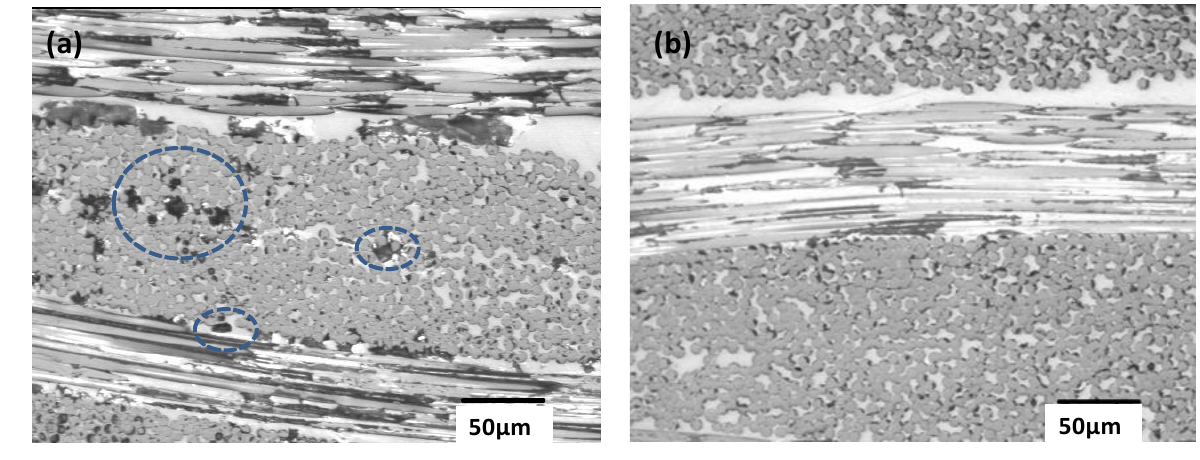
Figure 9. Optical microscopy images of ( a ) PPS/CF; and ( b ) PPS/IF-WS laminate. The dashed circles in ( a ) show macropores within the